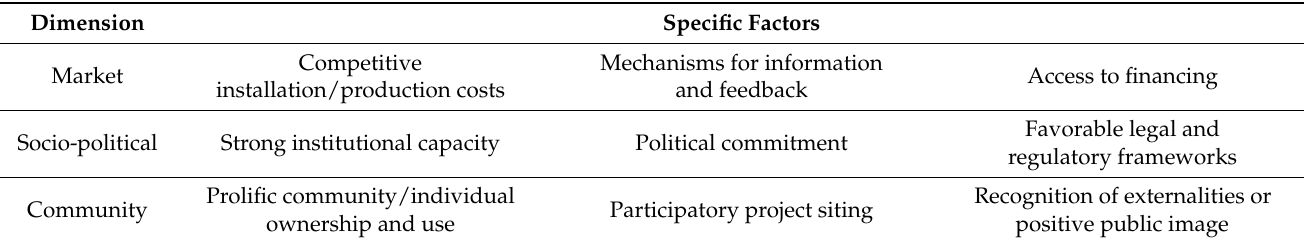
Table 1. Description of Sovacool and Lakshmi Ratan’s (2012) framework, Source: (Sovacool and Lakshmi Ratan, 2012). Dimension Specific Factors